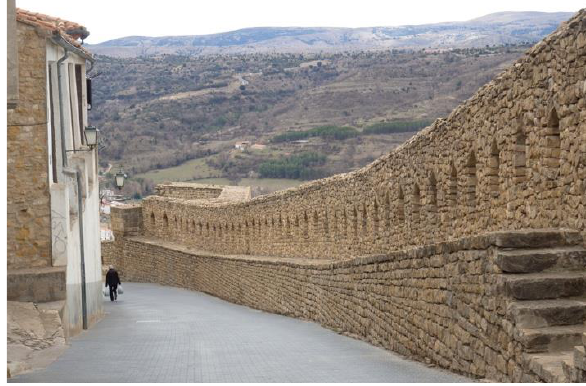
Figure 4. Relationship between the town and the external landscape in the south-western area (Source: S. Portela, 2018).